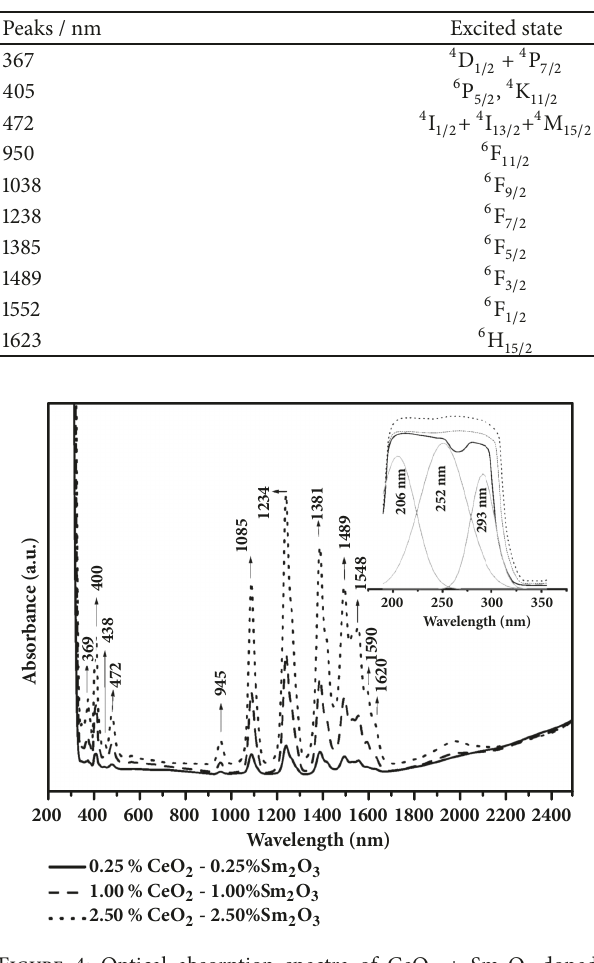
Table 2: Absorption peaks from Sm 2 O 3 -doped Na 2 O–ZnO–P 2 O 5 glasses and their excitation levels, ground state 6 H 5/2 󳨀→ .